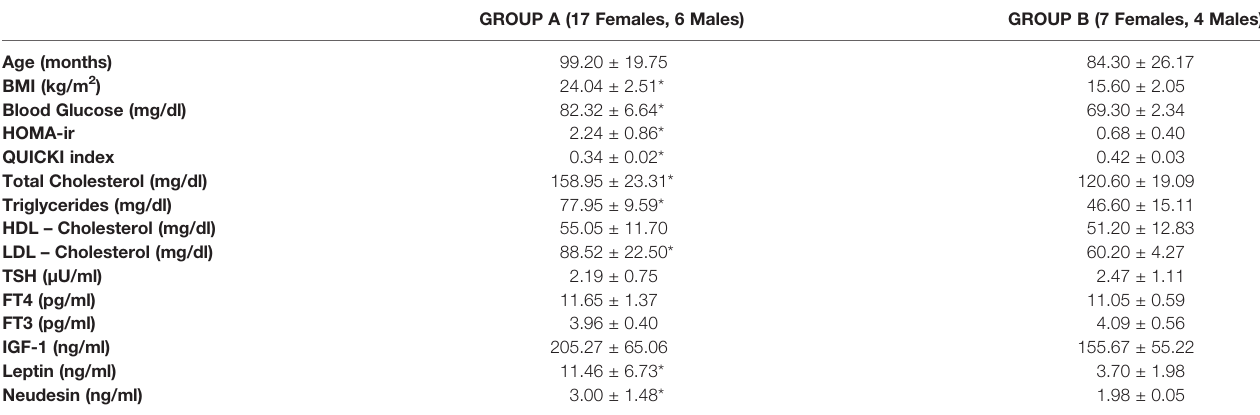
TABLE 1 | Mean ± SD of general, metabolic, hormonal characteristics and neudesin levels in the two groups. GROUP A (17 Females, 6 Males) GROUP B (7 Females, 4 Males)